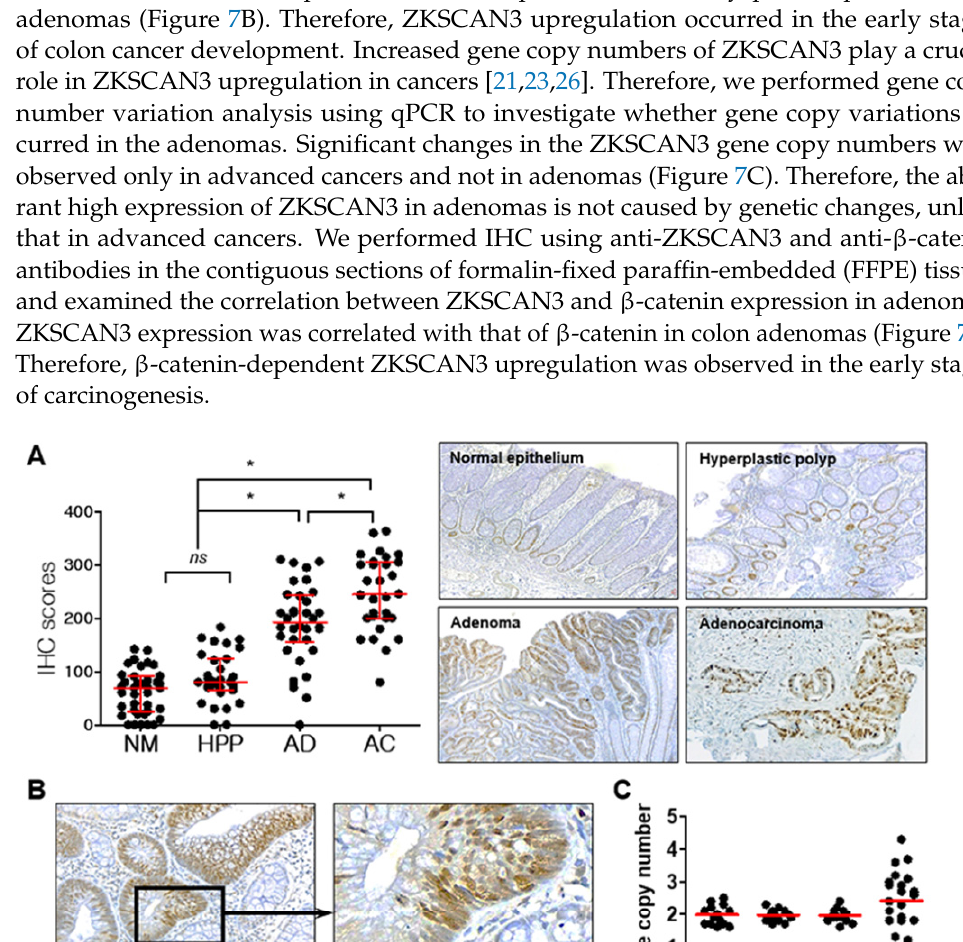
Figure 7. ZKSCAN3 upregulation in the early stage of the adenoma–carcinoma sequence. ( A ) Dis- tribution of IHC scores in the normal colonic epithelium (NM; n = 38), non-neoplastic hyperplastic polyps (HPP; n = 31), adenomas (AD; n = 34), adenocarcinomas (AC; n = 30), and their representative microscopic images (right panel). Optical magnification, ×100. Red bars represent the median with quartiles of the IHC scores. Statistical significance was determined using one-way ANOVA fol- lowed by Duncan’s test (* p < 0.01). ( B ) Representative ZKSCAN3 IHC images of adenoma with dysplasia. Optical magnification, ×200 (left panel) and ×400 (right panel). ( C ) Gene copy numbers of normal epithelium ( n = 14), non-neoplastic hyperplastic polyps ( n = 16), dysplastic adenomas ( n = 14), and adenocarcinomas ( n = 22). ( D ) Correlation between IHC scores of ZKSCAN3 and β -catenin. Data were obtained from 29 cases of adenomas and analyzed through Pearson correlation ( p < 0.01). Representative IHC images are shown in the right panel. Optical magnification, 100 (middle panel) and ×200 (right panel). ns, not significant. 3. Discussion The high expression of β -catenin caused by mutations in components of the WNT signaling pathway, such as the APC tumor suppressor, is one of the most frequent and early genetic changes that occur in colon cancer [35,36]. Cytoplasmic β -catenin translo- cates to the nucleus, where β -catenin/TCF complexes drive the expression of target genes, such as c-Myc and cyclin D1 [37,38]. This promotes sustained cell growth and proliferation. Therefore, identification of the early transcriptional targets of the β -catenin/TCF complex is of paramount importance for understanding the molecular steps involved in colon car- cinogenesis. We identified ZKSCAN3 as a downstream target of the WNT/ β -catenin/TCF signaling pathway in colon cancer. GO and KEGG pathway analyses indicated that DEGs in ZKSCAN3 KO cells were associated with cell cycle regulation, including the spindle assembly checkpoint, G1/S and